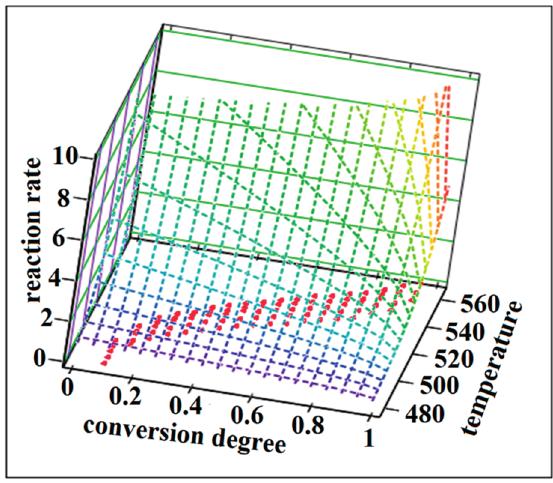
Figure 10. The reaction rate surfaces in 3D space with the coordinates ( β ·d α /d T ; α ; T ) for the SB1